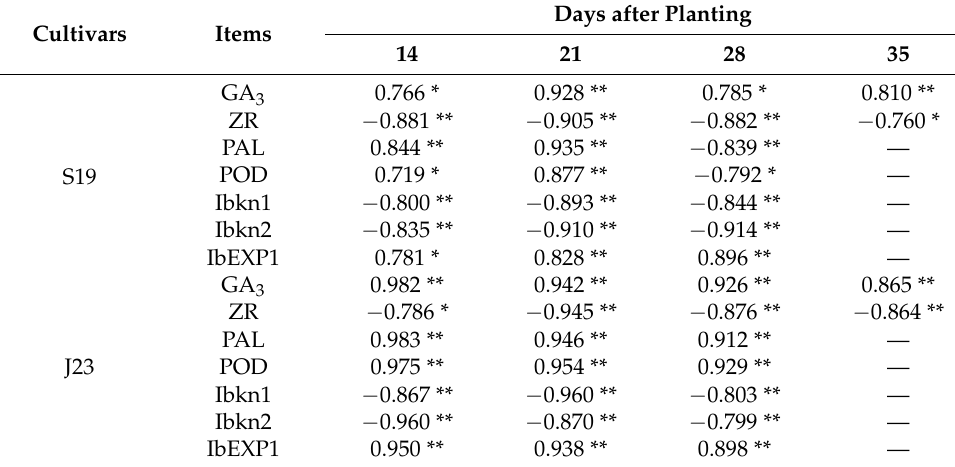
Table 5. Coefficients of correlation of GA 3 and ZR content; PAL and POD activity; Ibkn1 , Ibkn2 , and IbEXP1 expression with lignin